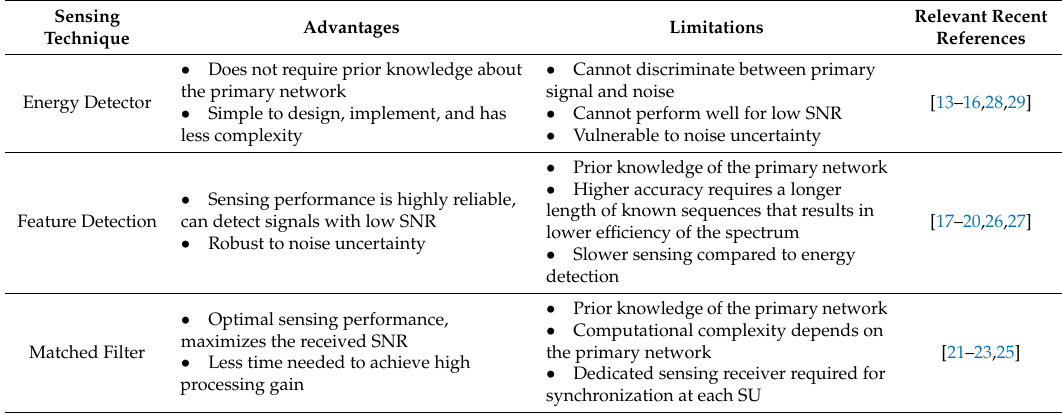
Table 1. Summary for various non-cooperative sensing techniques for the cognitive wireless sensor network (CWSN). SNR: signal-to-noise ratio.